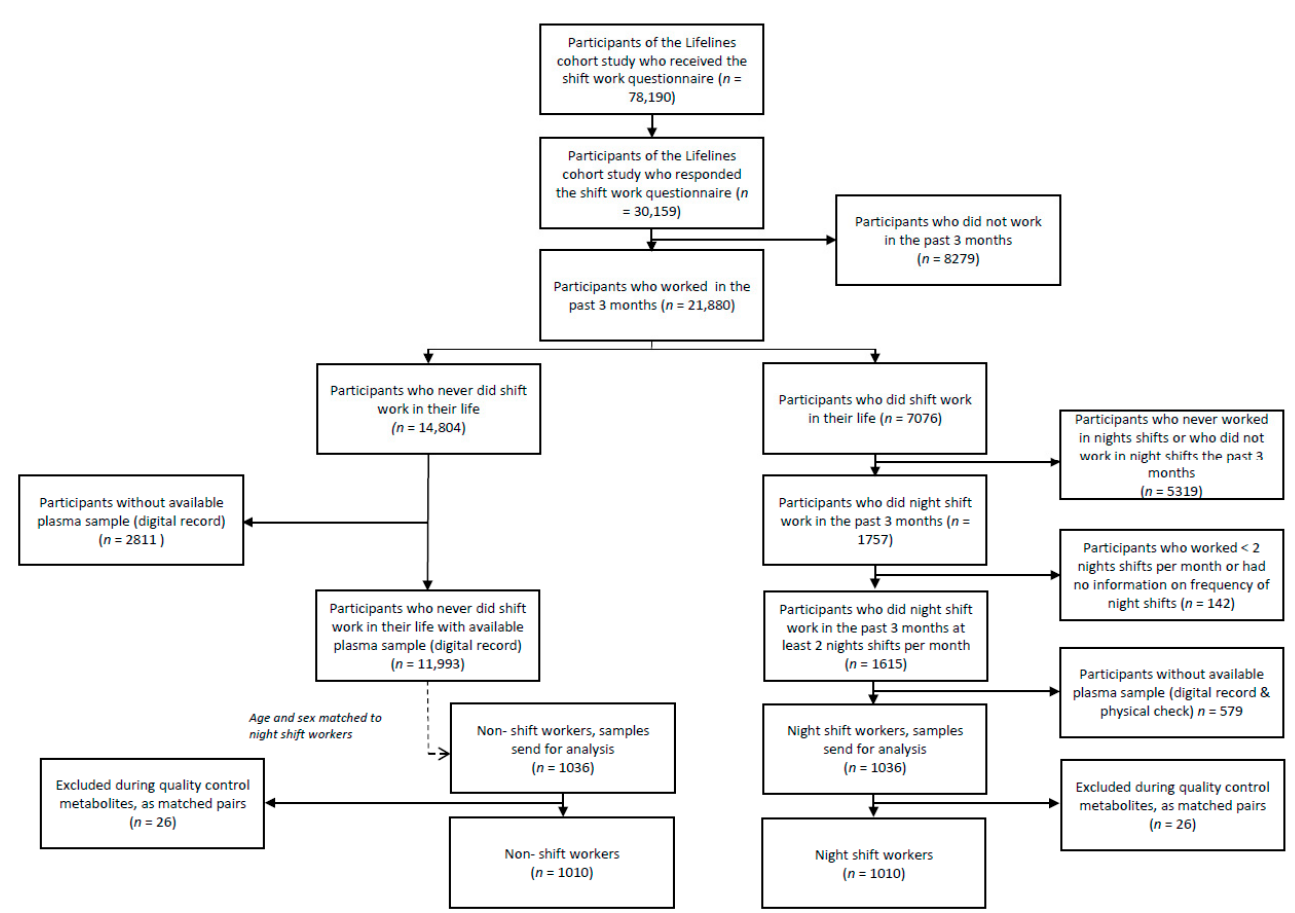
Figure 1. Flowchart of inclusion and exclusion of study population.